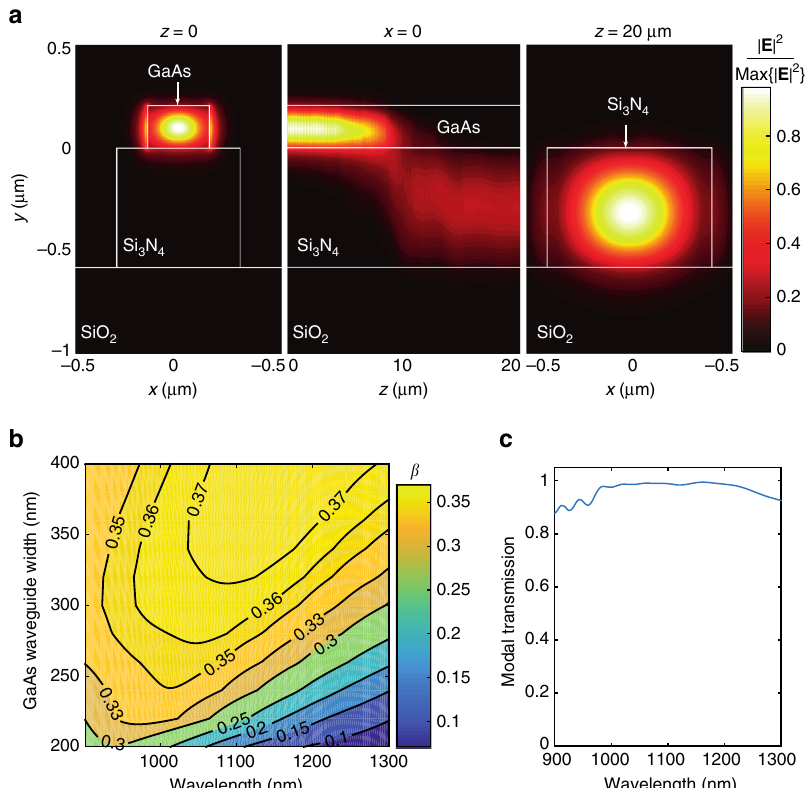
Fig. 2 Nanophotonic design. a Left panel: electric fi eld distribution for the fundamental TE GaAs supermode of the waveguide stack in Fig. 1c, with dimensions speci fi ed in the main text. Center panel: electric fi eld distribution across the mode-transformer cross-section, for a GaAs mode launched at z = 0. At z ≈ 10 μ m, the GaAs and Si 3 N 4 guides are phase-matched, and power is ef fi ciently transferred from the top GaAs to the bottom Si 3 N 4 guide. Right panel: fundamental TE mode of the Si 3 N 4 waveguide at the end of the mode transformer. b Coupling ef fi ciency ( β ), as a function of GaAs width and emission wavelength, of photons emitted by a dipole located at x = 0 and 74 nm below the top surface, into the GaAs waveguide mode traveling in either the +z or − z direction. c Modal power conversion ef fi ciency from the GaAs mode into the Si 3 N 4 mode in ( a ) as a function of